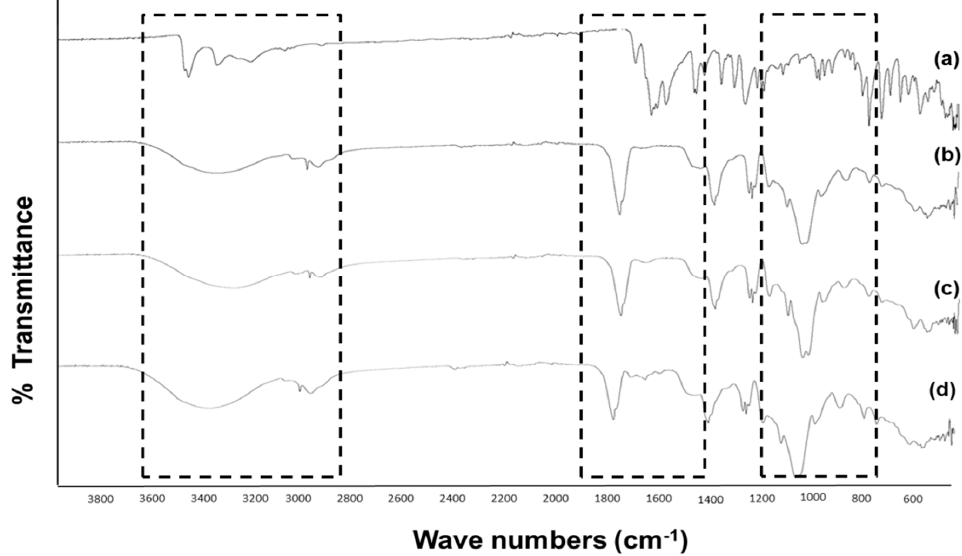
Figure 4. Comparison of FT-IR spectra of: ( a ) pure nepafenac, ( b ) pure HP β CD, ( c ) pure γ CD and ( d ) freeze-dried nepafenac/15% γ CD/8%HP β CD complex.